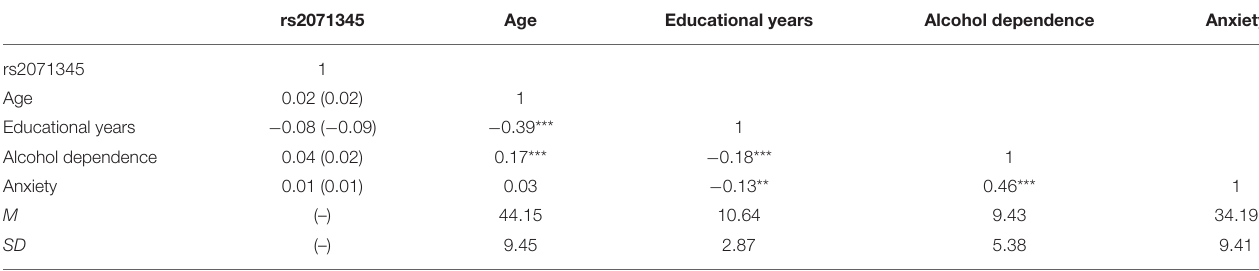
TABLE 1 | Descriptive statistics and correlations between the variables.